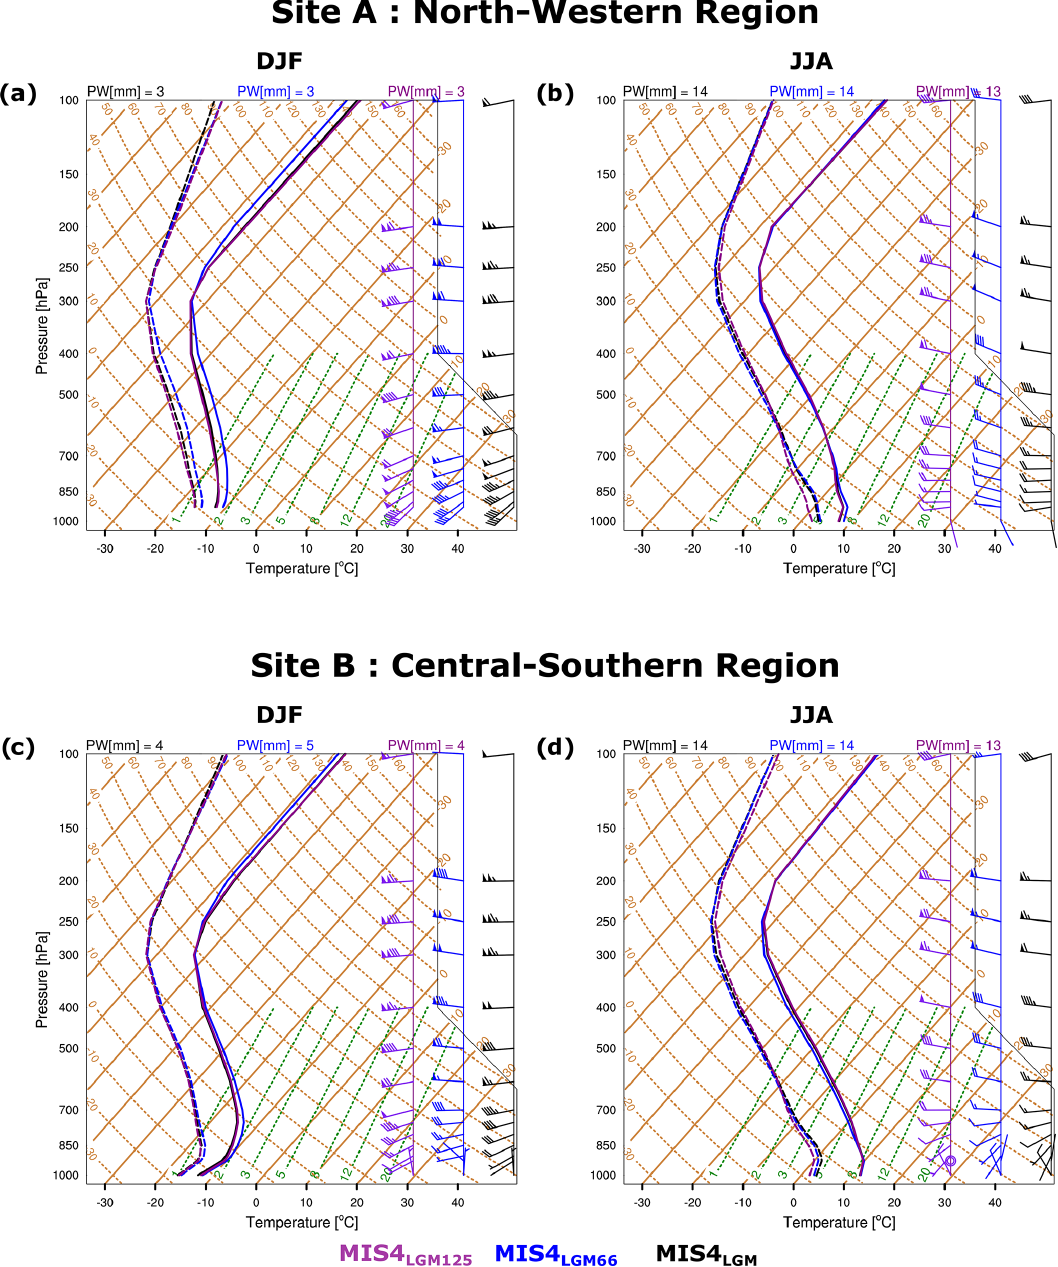
Figure 8. As Fig. 4 but for MIS4 LGM125 (purple), MIS4 LGM66 (blue) and MIS4 LGM100 (black).